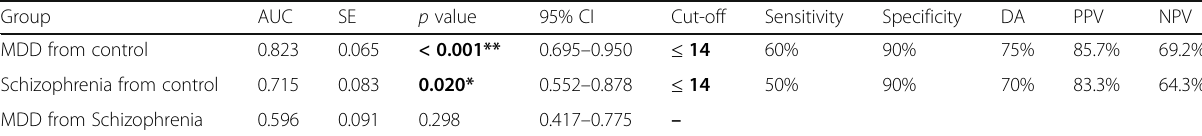
Table 4 Diagnostic performance of vitamin D in differentiation between study groups Group